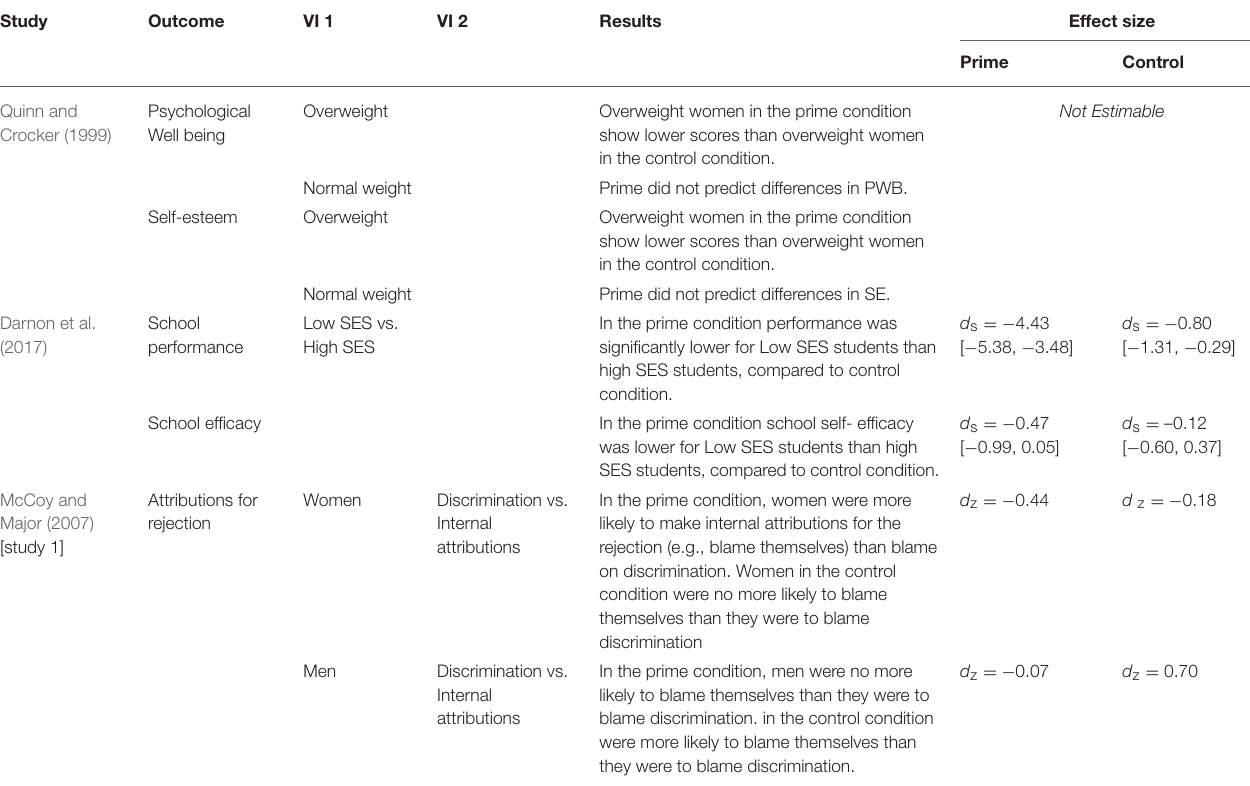
TABLE 5 | Summary of studies related with the Impact of Meritocracy on Self—Evaluations and Performance. Study